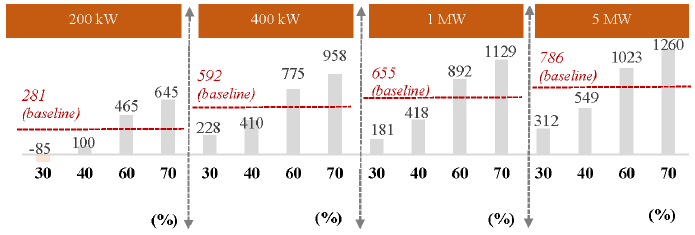
Figure 6. Sensitivity analysis–NPV/Power (€/kW) in function of percentage of self ‐ consumption.